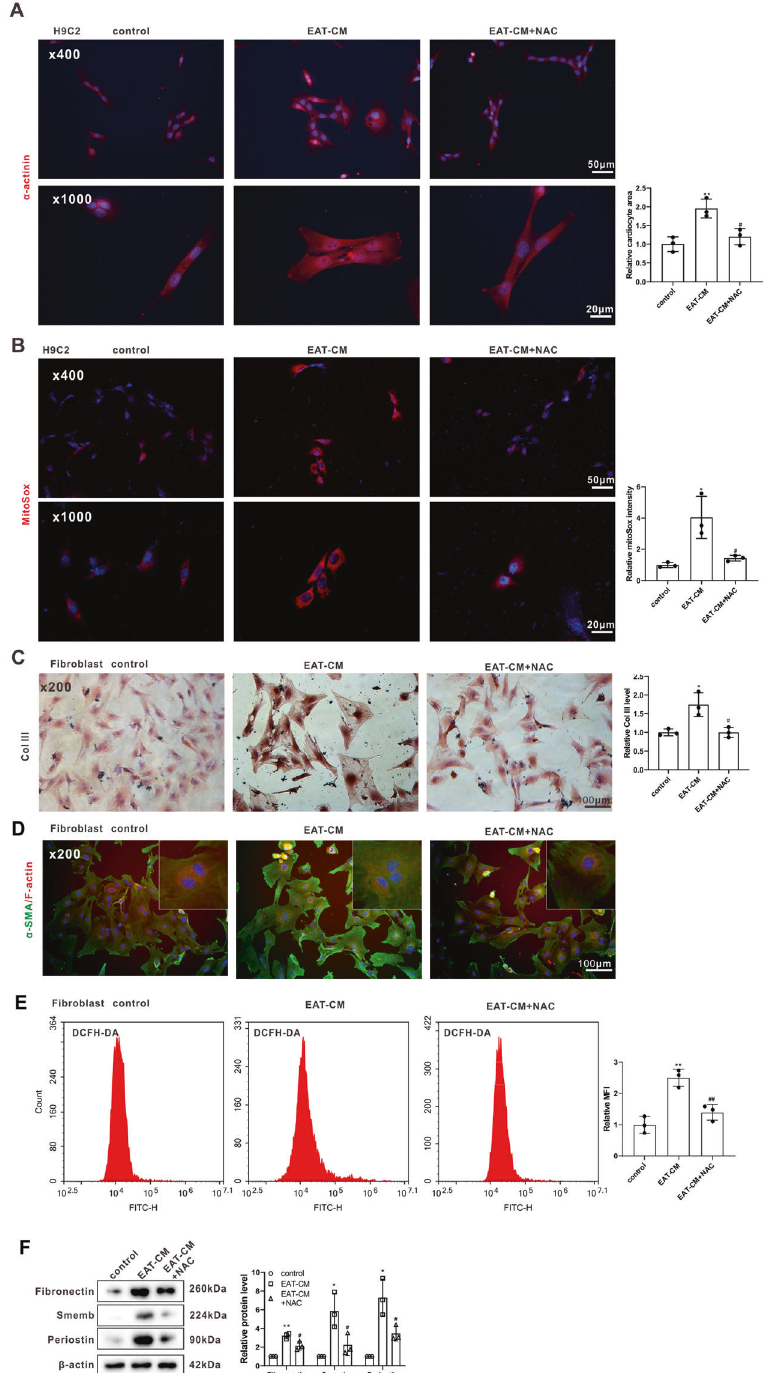
Fig. 3 Secretory products from EAT promoted cardiomyocyte hypertrophy and cardiac fi broblast activation by elevating ROS levels. Rat cardiomyocyte cell line H9C2 and primary rat cardiac fi broblasts were cultured in DMEM-F12 medium, EAT conditioned media (EAT-CM), or EAT-CM + N -acetyl-cysteine (NAC, 2 mM) for 72 h. A Immuno fl uorescent staining for α -actinin in H9C2 cells. B MitoSox fl uorescence probe was used to observe the mitochondrial superoxide content in H9C2 cells. Cell nuclei were counterstained with DAPI. C Immunohistochemical staining for collagen III (CoI III) in primary rat cardiac fi broblasts (scale bar = 100 µm). D Immuno fl uorescent staining for alpha-smooth muscle actin ( α -SMA) (green)/ fi lamentous actin (F-actin) (red) in primary rat cardiac fi broblasts (scale bar = 100 µm). Cell nuclei were counterstained with DAPI. E The intracellular ROS level in primary rat cardiac fi broblasts was analyzed by fl ow cytometry using a DCFH-DA fl uorescence probe. MFI: mean fl uorescence intensity. F The protein levels of fi bronection, smemb, and periostin in primary rat cardiac fi broblasts were measured by western blot. β -actin was used as an internal control. * P < 0.05, ** P < 0.01 vs H9C2 or primary rat cardiac fi broblasts cultured in DMEM-F12 medium (control); # P < 0.05, ## P < 0.01 vs H9C2 or primary rat cardiac fi broblasts cultured in EAT-CM